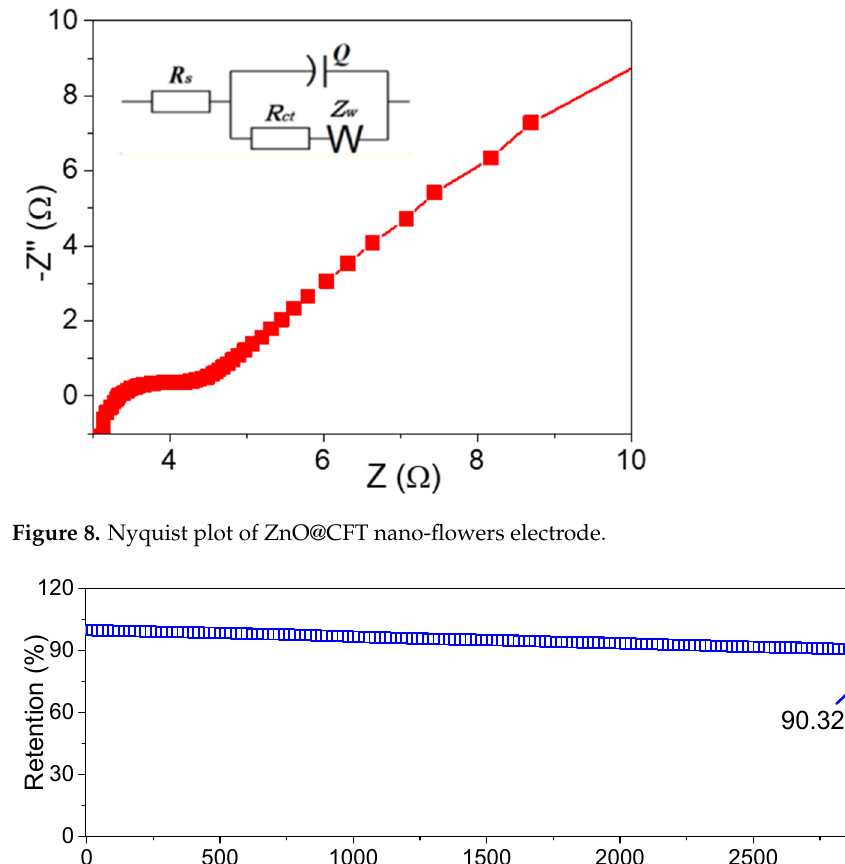
Figure 8. Nyquist plot of ZnO@CFT nano-flowers electrode.